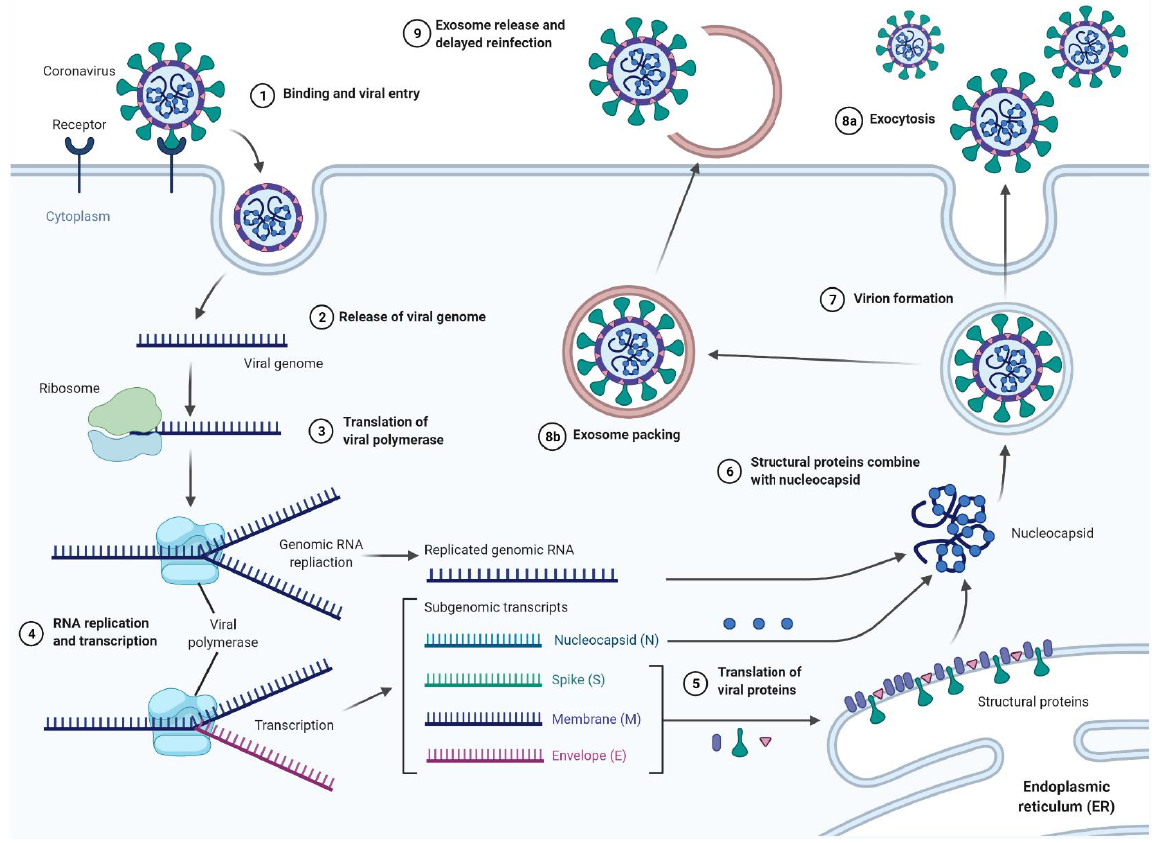
Figure 4. The process of SARS-CoV-2 virus infection, including the proposed mechanisms for exosome-based delayed reinfection. Created with BioRender.com.